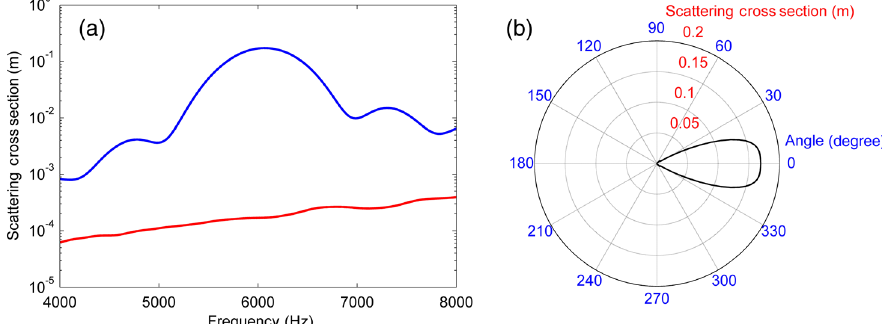
FIG. 4. (a) Scattering cross section versus frequency, where the blue (upper) and red (lower) curves describe the scattering cross section of the PT -symmetric cloak when the light is incoming from the left and right, respectively. (b) Scattering cross section versus the incident angle at the frequency 6 kHz, where θ ¼ 0 corresponds to the parallel propagation along the z direction from left to